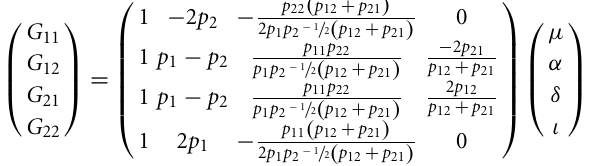
decomposition, coming from the fourth column of that